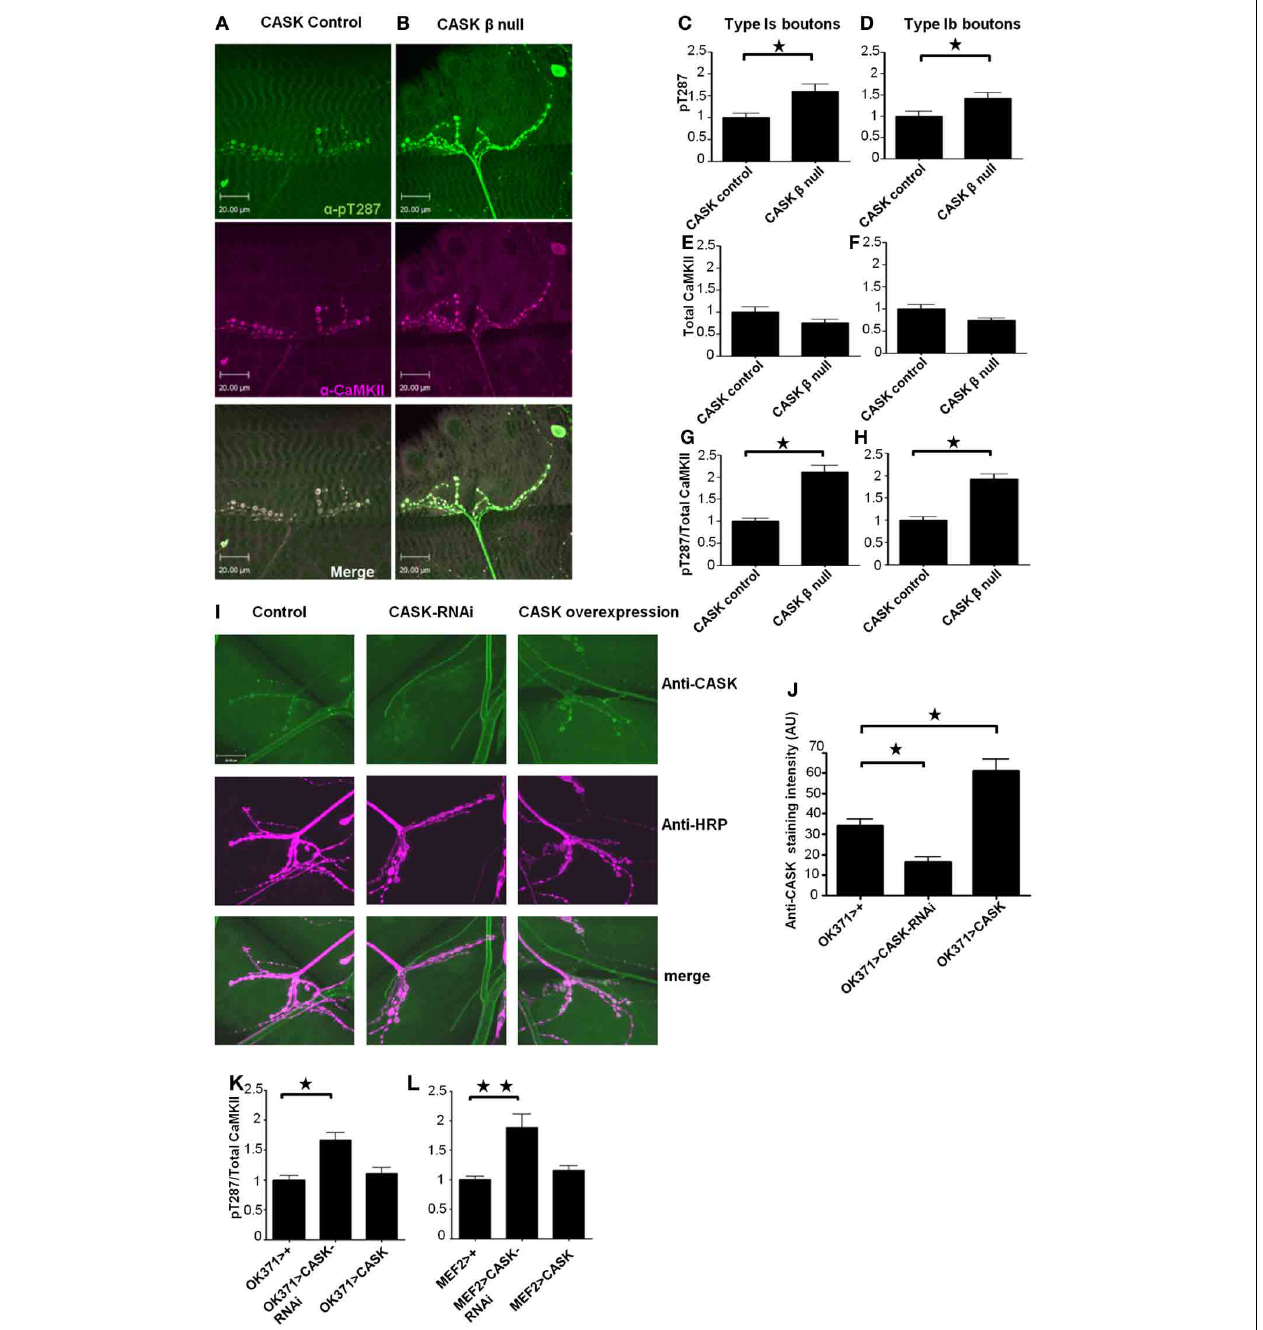
FIGURE 2 | The CaMK-like and L27 domain-containing version of CASK regulates CaMKII autophosphorylation at synapses. Compared to control (A) CASK β null larvae (B) exhibited increased levels of synaptic CaMKII autophosphorylation at T287 [as visualized in green using a phospho-specific antibody to CaMKII-T287 (Hodge et al., 2006)] relative to total synaptic CaMKII [visualized in magenta using an antibody raised against CaMKII (Hodge et al., 2006)]. Overlapping expression is shown in white. Removal of the CaM-Kinase and L27 domains of CASK caused an increase ( p < 0 . 05) in pT287 at 1s (C) and 1b (D) boutons. The total amount of CaMKII localized at synapses was not affected ( p > 0 . 05) by the removal of CASK (E,F) . The ratio of pT287 to total CaMKII (G,H) also